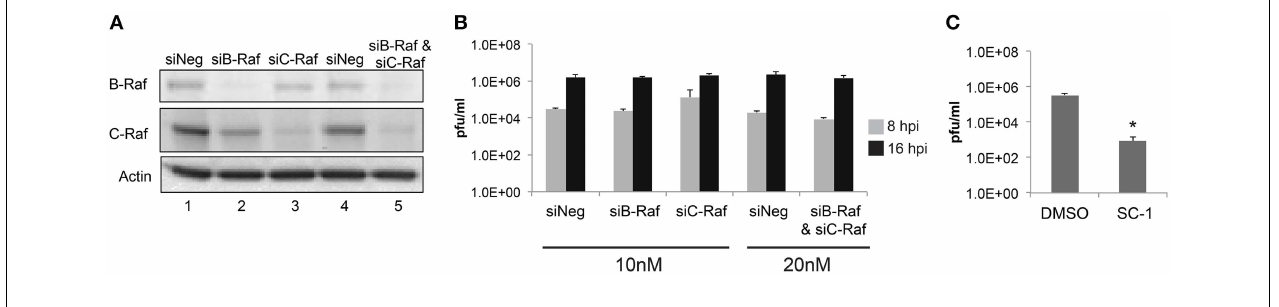
at 16 hpi and plaque assays were performed. (C) Cells were pre-treated and post-treated with SC-1 or DMSO and infected with MP12 MOI 0.1. Supernatants were collected 24 hpi and a plaque assay was performed. The average and standard deviation of three biological replicates are plotted. * p ≤ 0 . 01